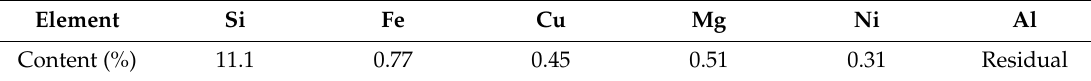
Table 1. Chemical composition of ZL019.